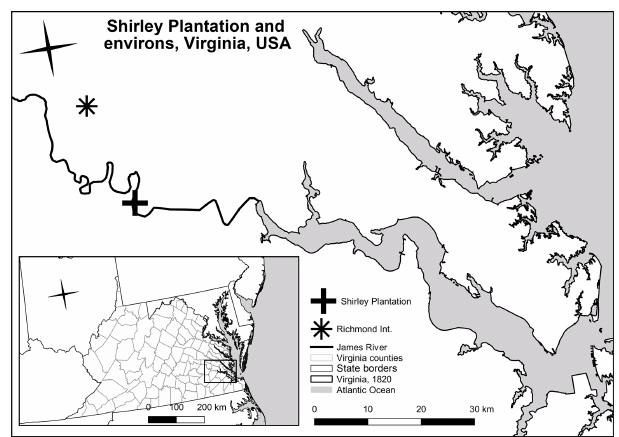
Figure 1. Map of Tidewater, Virginia. Shirley Plantation is located along the James River, 20km (12mi) southeast of the weather sta- tion at Richmond International Airport. The inset includes the po- litical boundaries in Virginia during the period of